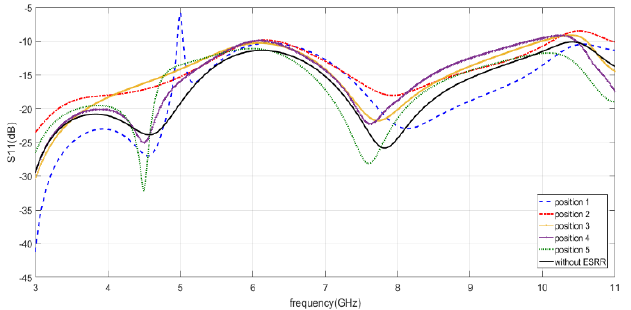
Figure 4: Simulated S11 characteristics of the UWB antenna with ESRR2 only using HFSS.